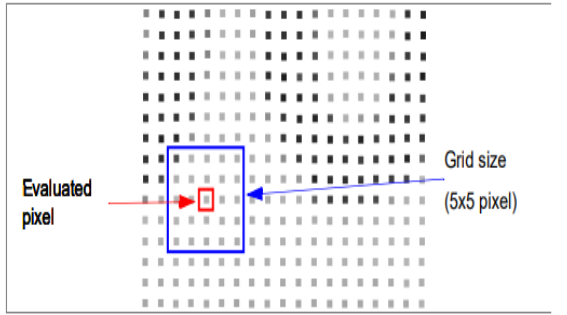
Figure 3. The area surrounding a scan point, in a 2D